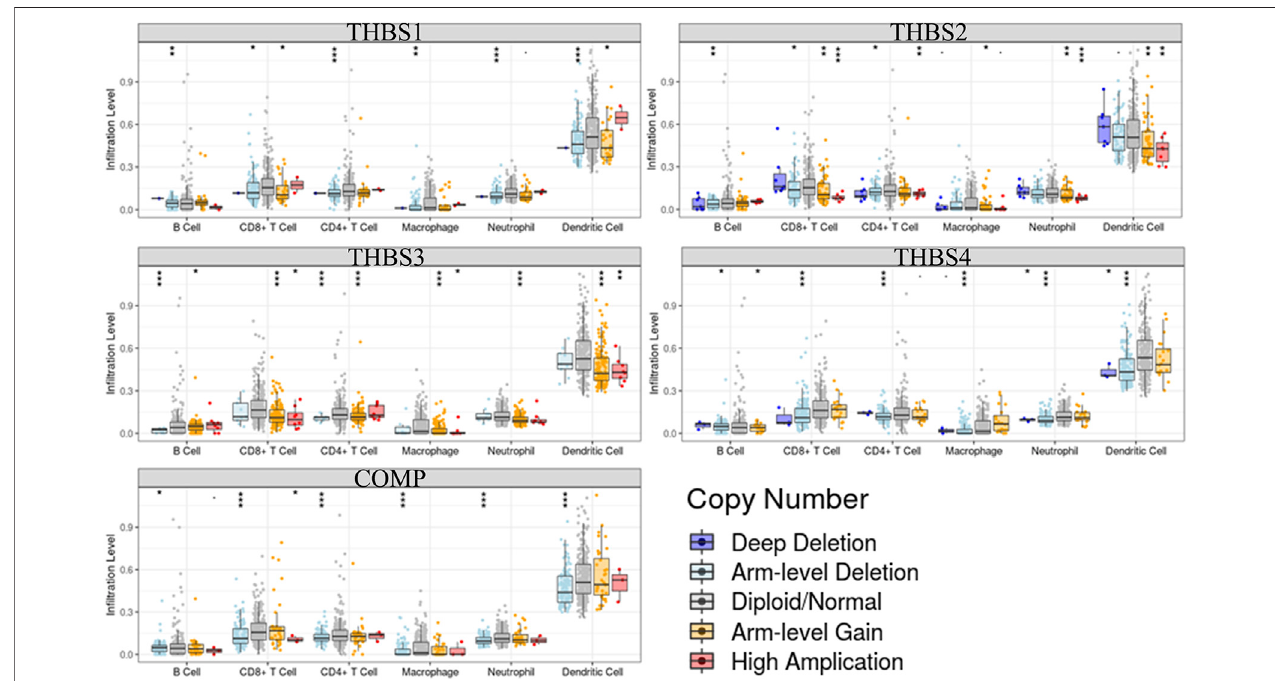
FIGURE 8 | Correlations between THBSs somatic copy number alterations and dominant immune cells in fi ltration levels (signi fi cant codes: 0 ≤ *** < 0.001 ≤ ** ≤ 0.01 ≤ * ˂ 0.05 ≤ C < 0.1, TIMER).